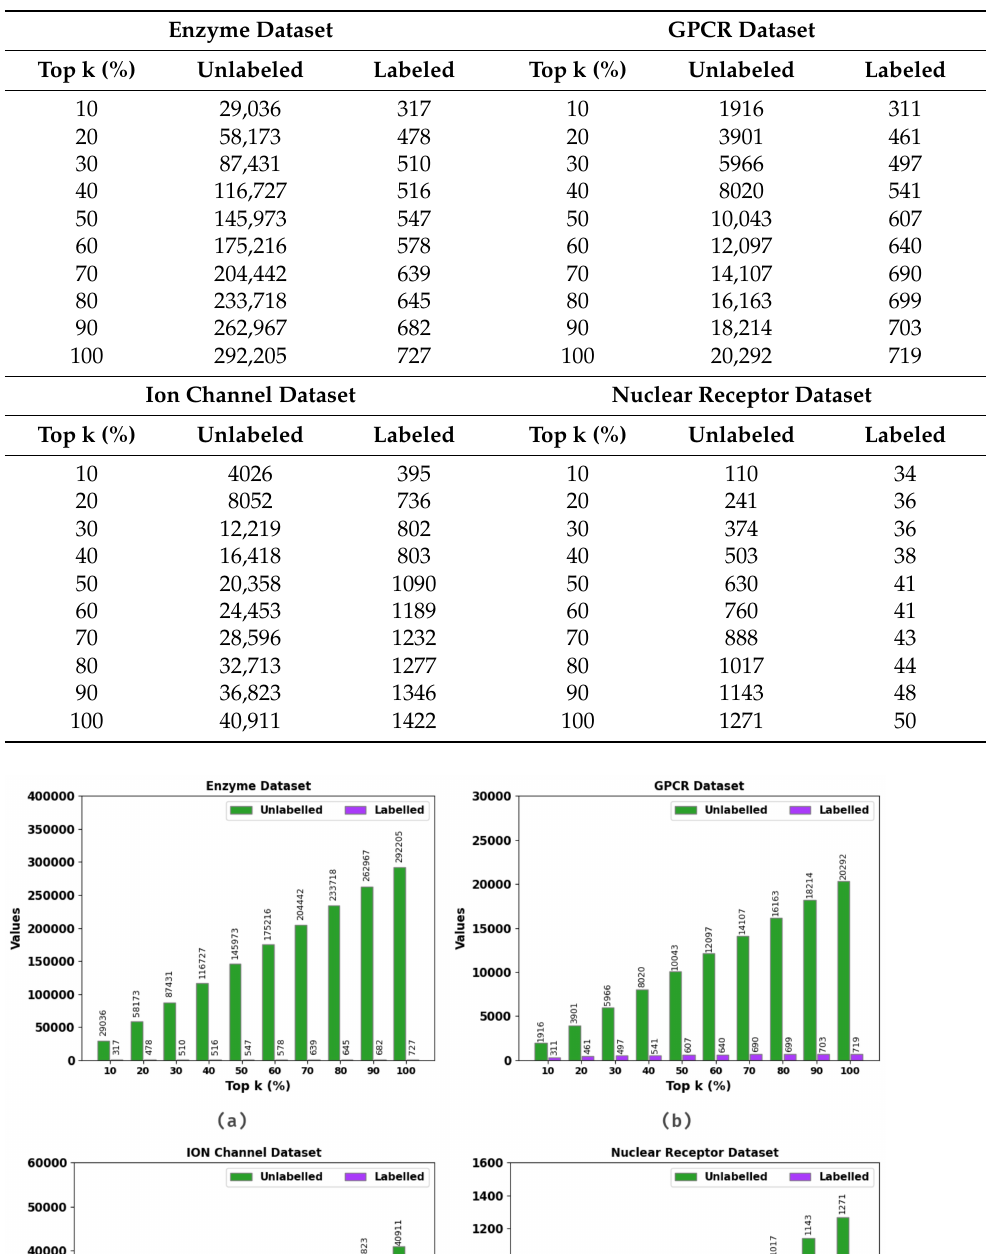
Table 2. Analysis results of the SSODL-DDIP technique applied to distinct datasets.